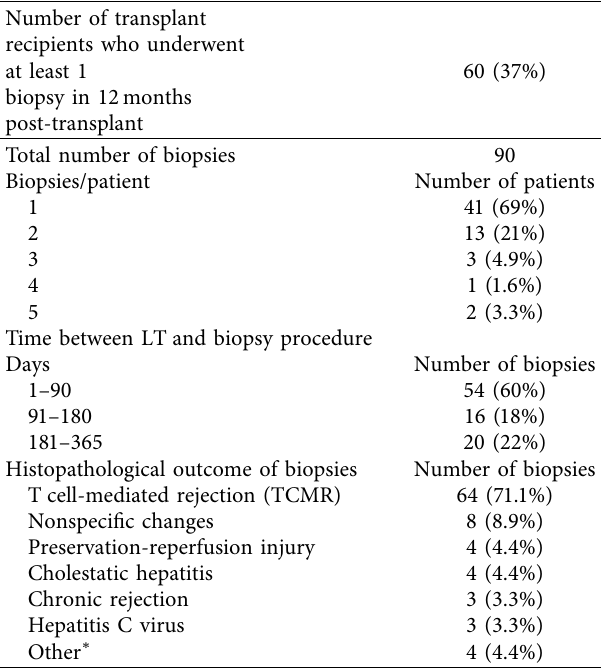
Table 3: Biopsy characteristics and histopathological outcome of the